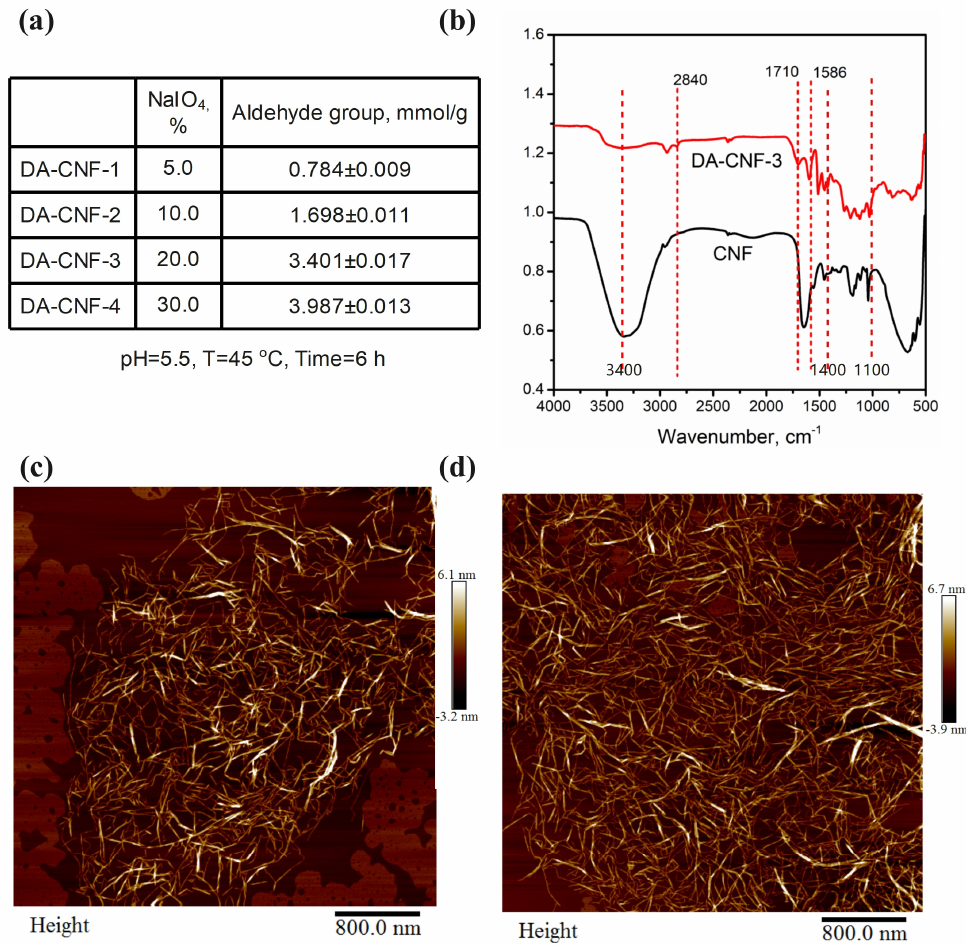
Figure 2. Characteristics of DA-CNF. ( a ) Oxidated CNF by sodium periodate. ( b ) FTIR spectra of CNF and DA-CNF. ( c ) AFM height images of CNF. ( d ) AFM height images of DA-CNF.